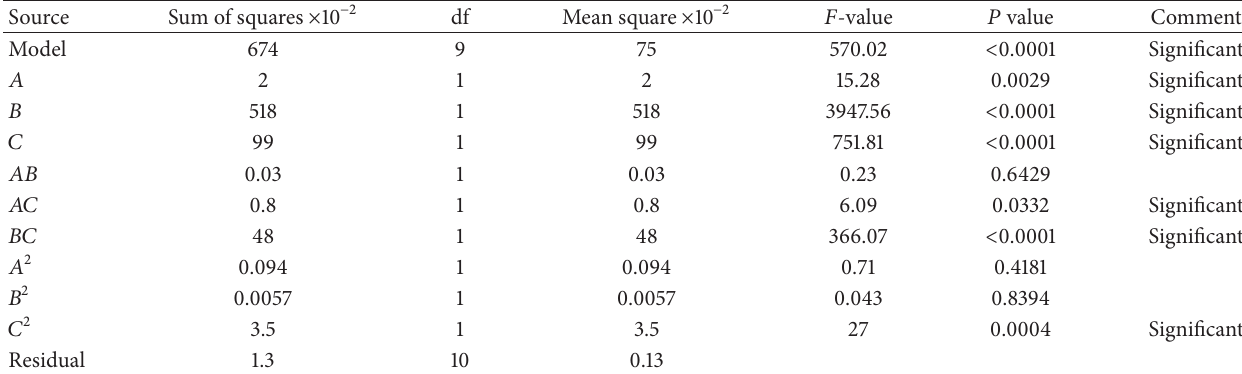
Table 5: ANOVA table for adsorption capacity (model for response 𝑌 2 ).